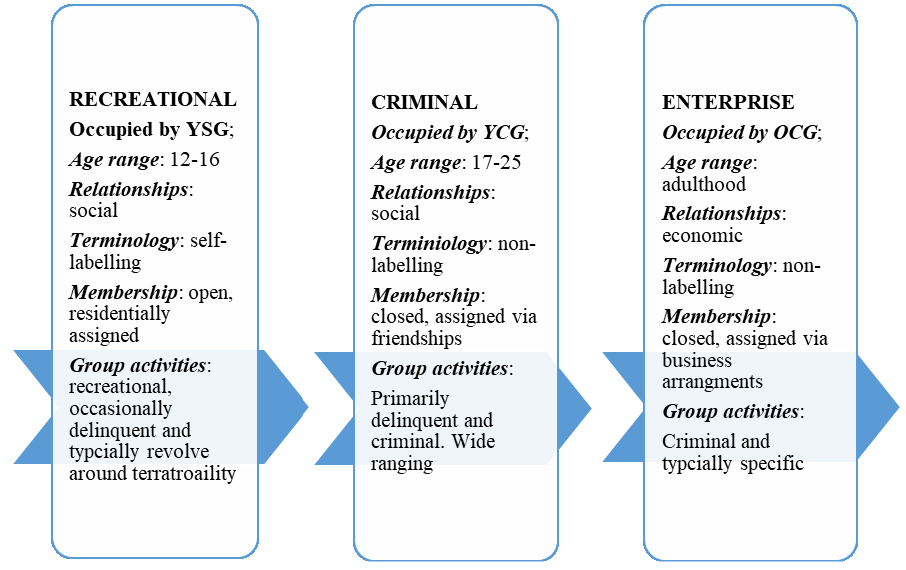
Figure 1. The gang as an evolving phenomenon.